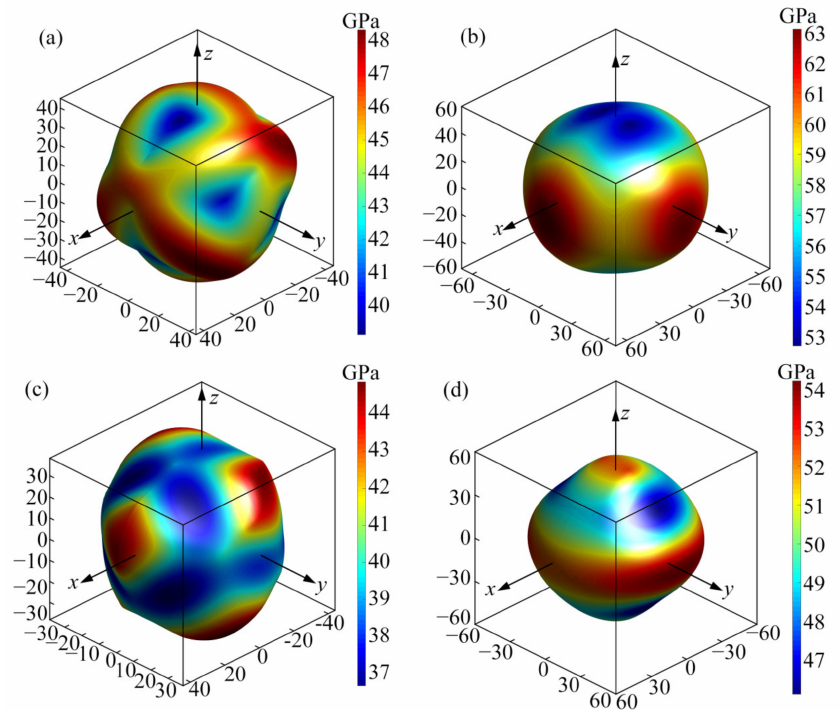
Figure 4. The 3D directional dependence of G : ( a ) the maximum G of η (cid:48) -Cu 6 Sn 5 ; ( b ) the maximum G